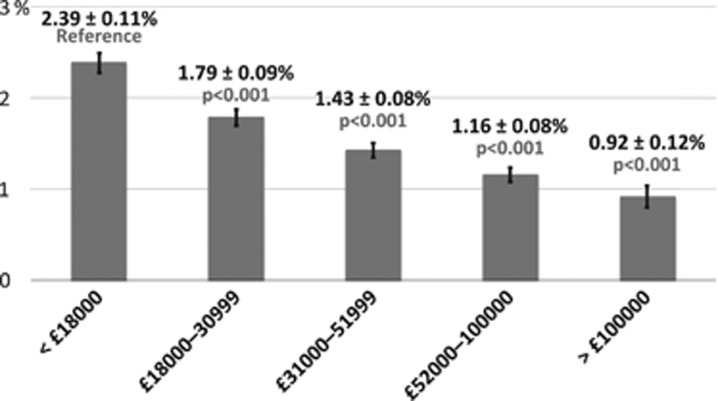
Frequency of self-reported glaucoma by annual income (%±SE). The rate of self-reported glaucoma is inversely related to income, and extends across the full range of the income spectrum.